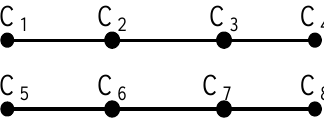
Figure 6. Separability graph.